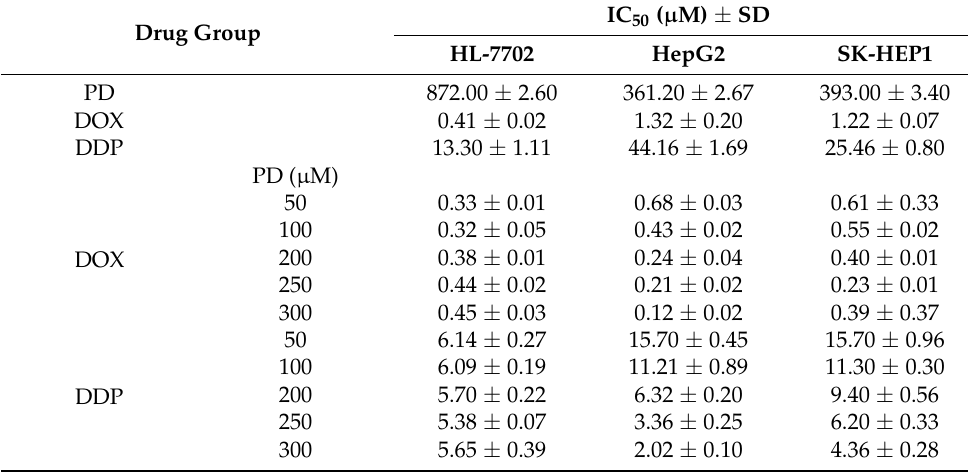
Table 1. The IC 50 (half maximal inhibitory concentration) values of the individual and combinatorial treatments by PD, DOX and DDP in HL-7702, HepG2 and SK-HEP1 cells for 48